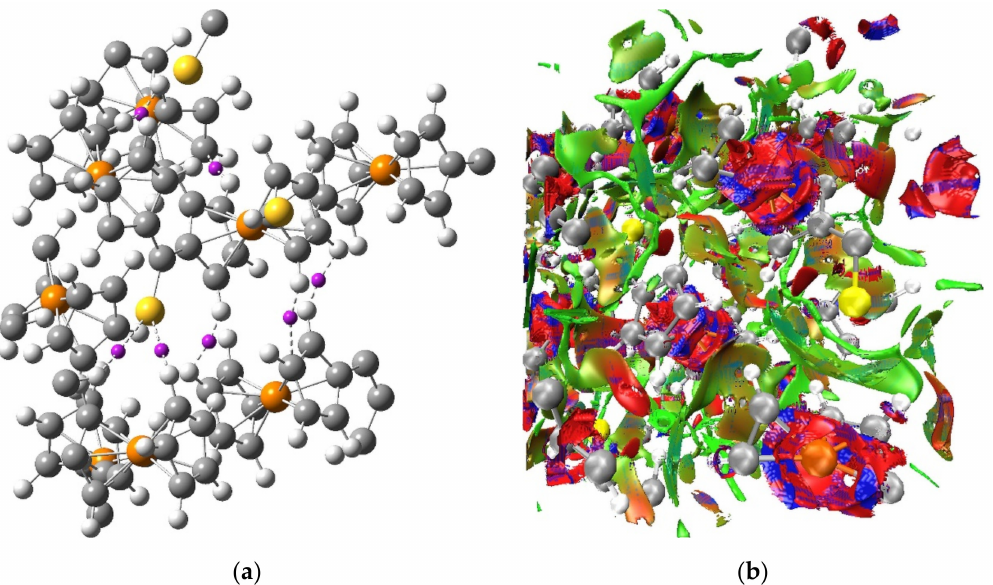
Figure 9. ( a ) QTAIM critical points and ( b ) NCI isosurface for the PBE-D / SVP-optimized unit cell of Fc 2 CS. Only several critical points corresponding to various intermolecular contacts are shown. These critical points are marked with small purple balls. The NCI isosurface is plotted with a reduced density gradient isovalue of 0.5 a.u. and this isosurface is colored from blue to red according to sign( λ 2 ) ρ ranging from its negative to positive values, respectively. Colors coding individual elements are the same as in Figure